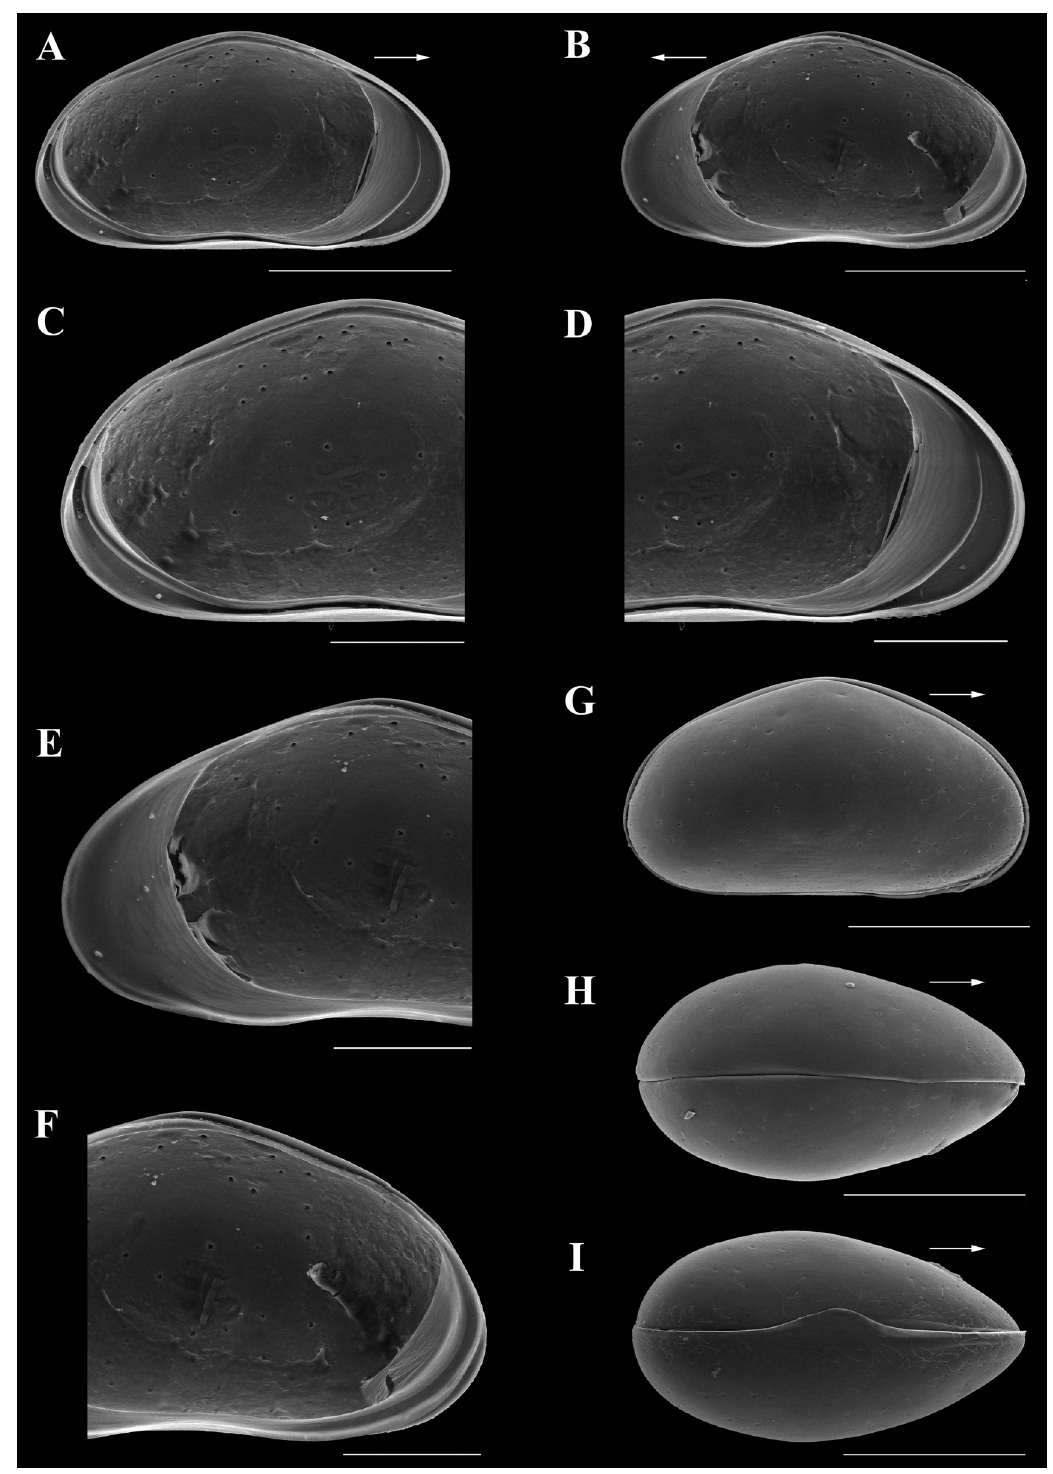
Fig. 8. Brasilodopsis baiabonita gen. et sp. nov. from Bonito, State of Mato Grosso do Sul, ♀. A . LVi (MZUSP 41840). B . RVi (MZUSP 41840). C . LVi, detail of posterior part (MZUSP 41840). D . LVi, detail of anterior part (MZUSP 41840). E . RVi, detail of anterior part (MZUSP 41840). F . RVi, detail of posterior part (MZUSP 41840). G . CpRl (MZUSP 41841). H . CpD (MZUSP 41842). I . CpV (MZUSP 41843). Scale bars: A–B, G–I = 300 µm; C–F =